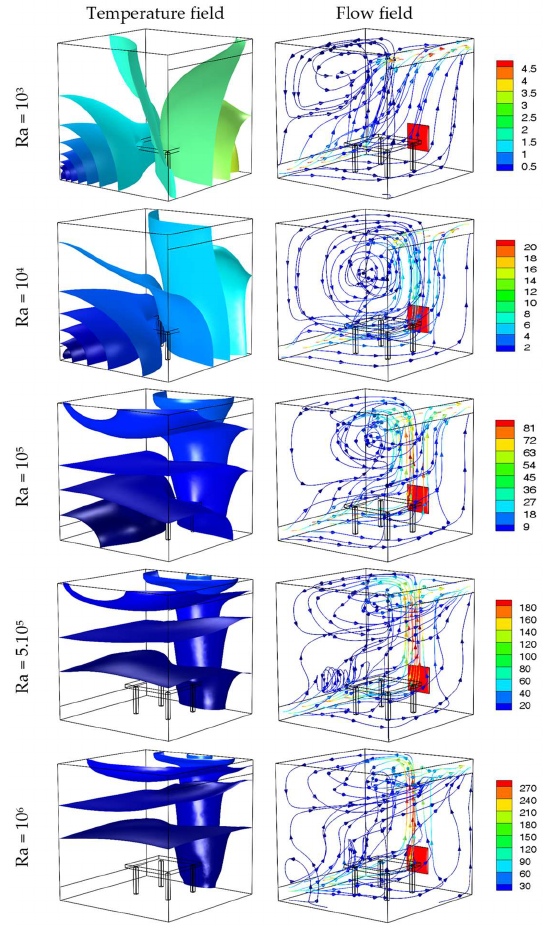
Figure 7. Effect of Rayleigh number variation on the distribution of temperature iso-surfaces and particle trajectories for a heat source position as indicated in case 3.